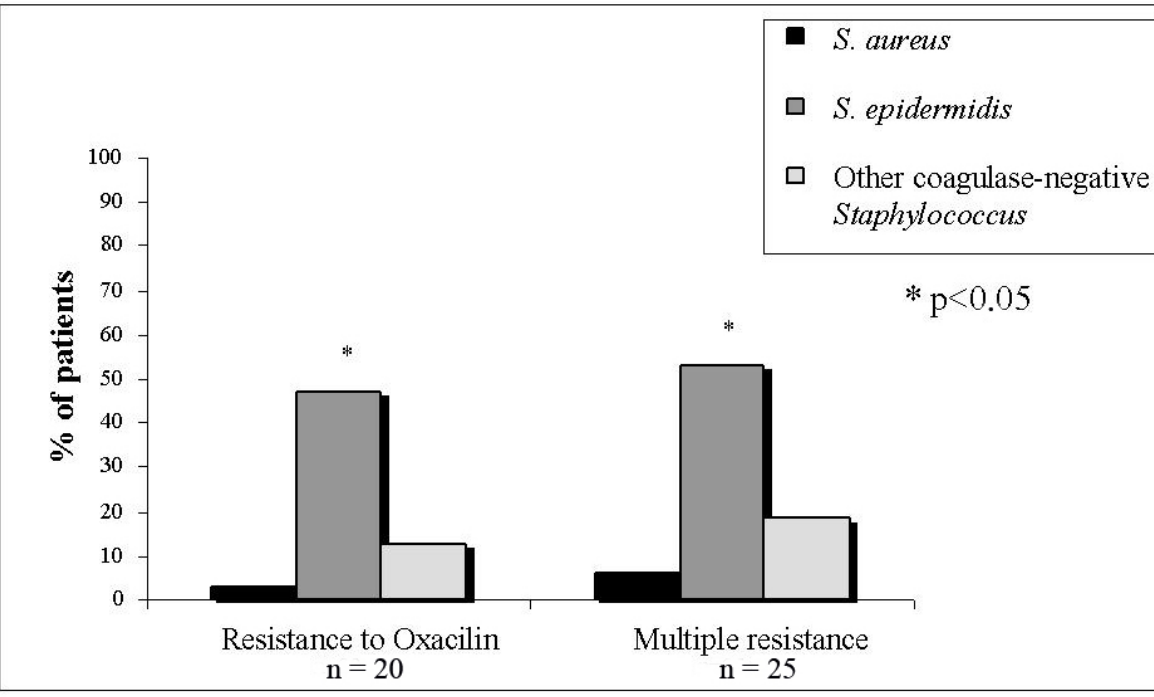
Figure 2. Frequency of oxacillin-resistant Staphylococcus and in vitro multi-drug resistance among 32 patients subjected to peritoneal dialysis at